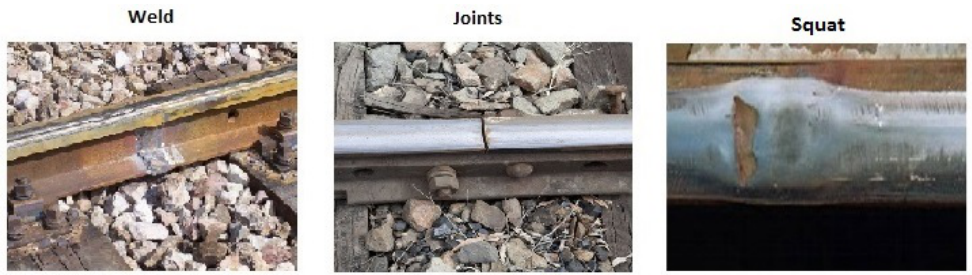
Figure 1. Types of anomalies